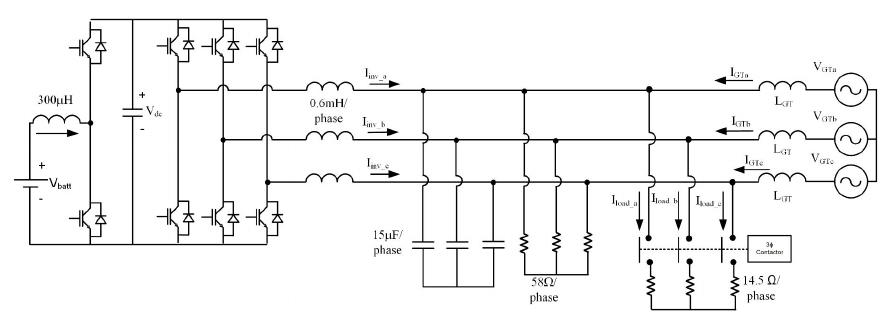
Figure 12. Circuit schematic of the laboratory layout for the experimental validation of the pri- mary